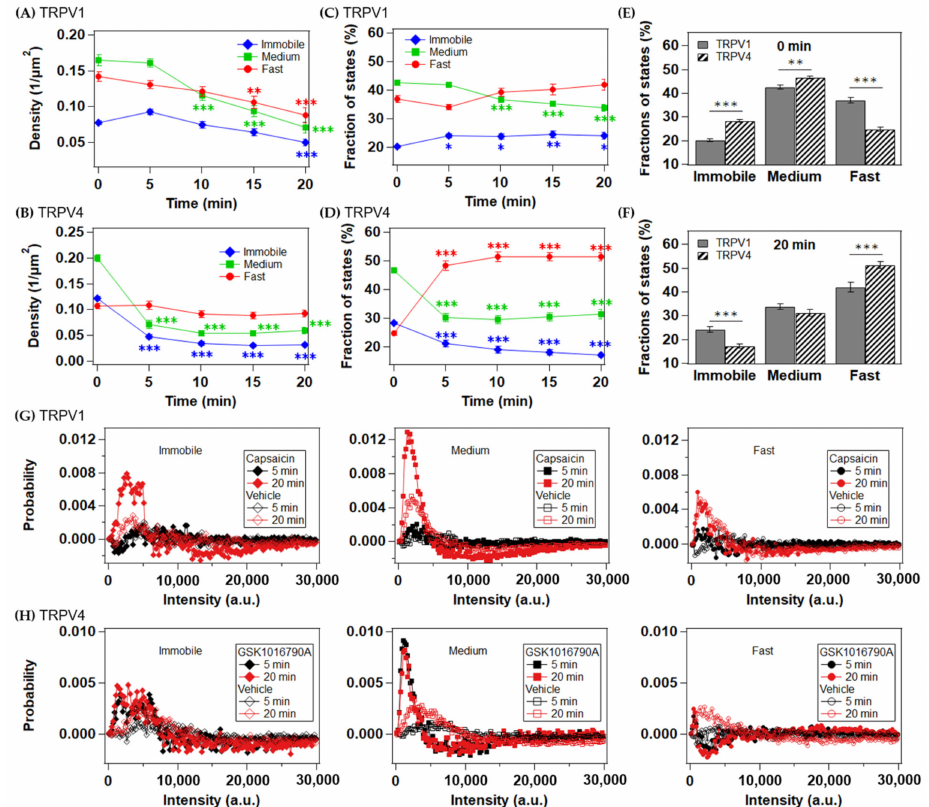
Figure 4. Agonist-induced changes in the membrane dynamics of the TRPV1 and TRPV4 channels. ( A , B ) Time-dependent changes in the density of each diffusion state of JF549-labeled TRPV1 upon capsaicin (300 nM) stimulation ( A ) and TRPV4 upon GSK1016790A stimulation ( B ). ( C , D ) Time-dependent changes in the fractions of the diffusion states of JF549-labeled TRPV1 ( C ) and JF549-labeled TRPV4 ( D ) after activation. The immobile, medium, and fast states are shown in blue, green, and red, respectively. Data are means ± SEM of 17–22 cells. ** p < 0.01, *** p < 0.001 (one-way ANOVA followed by Dunnett’s multiple-comparisons test versus basal level). ( E , F ) Comparison of the diffusion state fractions of TRPV1 and TRPV4 at 0 min ( E ) and 20 min ( F ). ** p < 0.01, *** p < 0.001; two-tailed t -test when compared with the same diffusion state of TRPV1. ( G , H ) Time-dependent changes in the intensity of JF549-labeled TRPV1 ( G ) and JF549-labeled TRPV4 ( H ) after stimulation with vehicle (black) or agonist